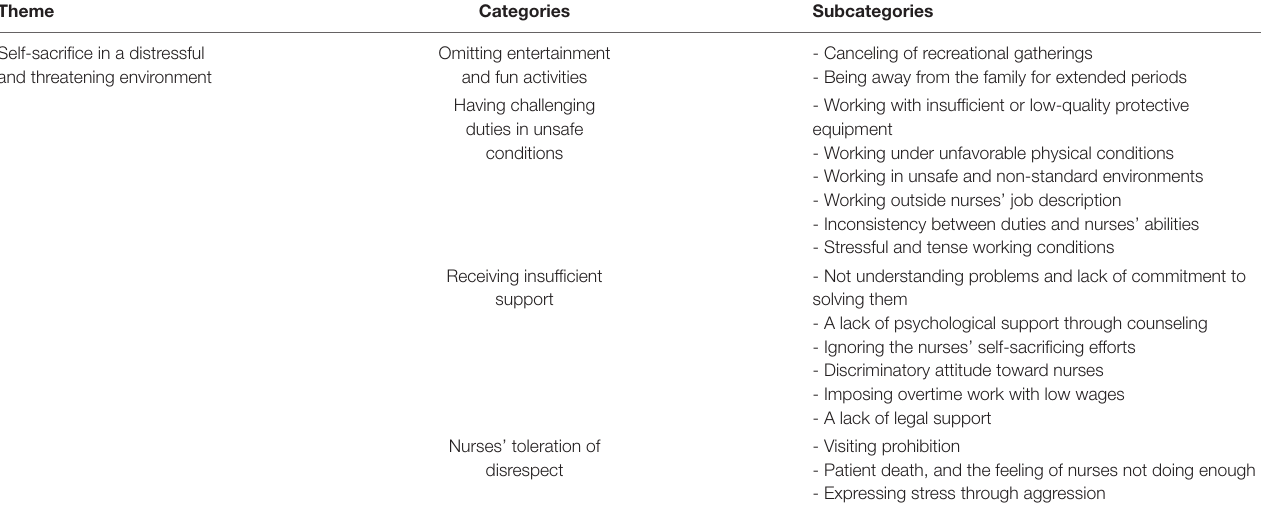
TABLE 3 | The category and subcategory related to the experiences of nurses of workplace violence in